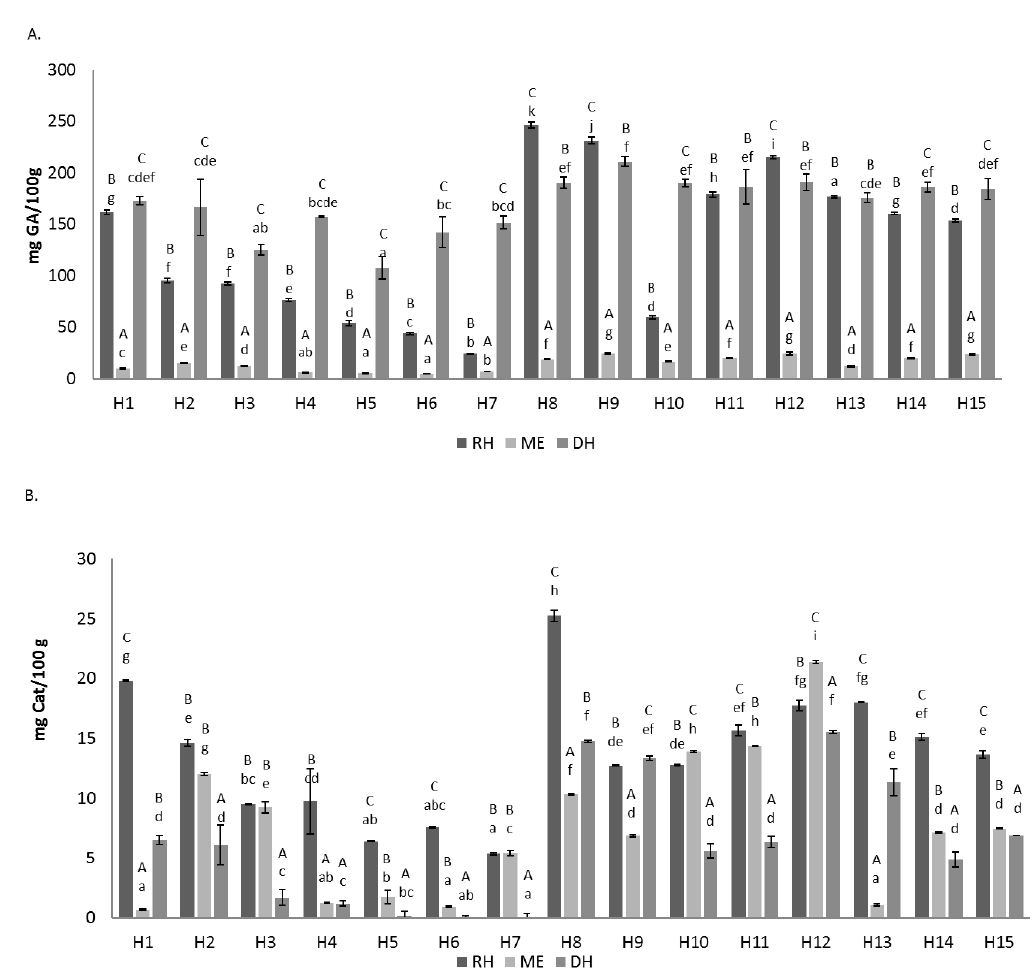
Figure 1. Total phenols ( A ) expressed as mg of gallic acid/100 g of honey and total flavonoids, and ( B ) expressed as mg of catechin/100 g of honey of raw honeys (RH), methanolic extracts (ME) and digestive extract (DH). Error bars represent the standard deviation for each data point. Different capitals letters (A–C) indicate significant differences ( p < 0.05) between extractions comparing the same sample. Different lowercase letters (a–g) indicate significant differences ( p < 0.05) between samples with the same extraction.